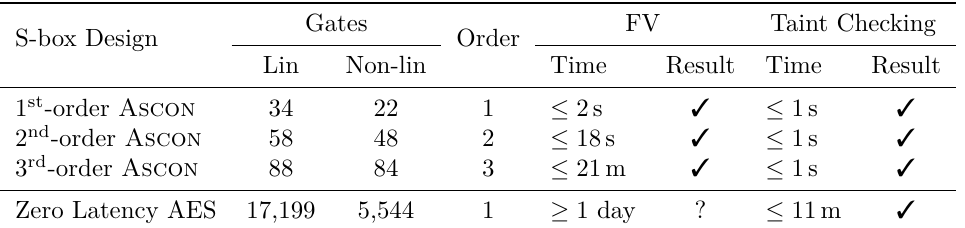
Table 4: Side-channel resistance verification results for the low-latency Ascon and the first-order zero latency AES S-box